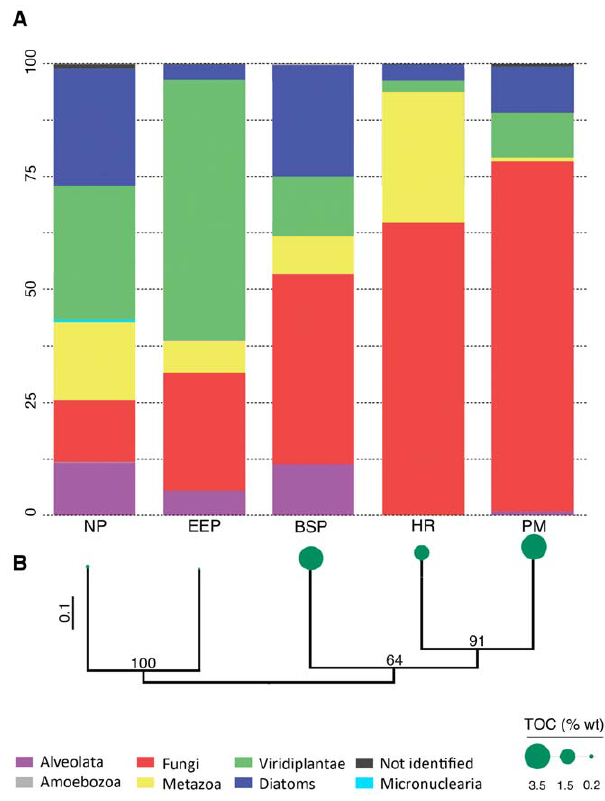
Figure 1. Alpha and beta diversity of pyrosequenced eukary- otic rRNA amplicons from five subseafloor sites representing various marine subsurface provinces. (a) Kingdom and phylum- level affiliation of eukaryotic rRNA sequences. Percentage of total reads is presented on the y-axis, samples were normalized to the number of sequences detected in the sample with the smallest number of sequences prior to comparison and UniFrac. (b) Hierarchical clustering of the eukaryotic rRNA dataset and phylogenetic distances between samples was calculated using weighted UniFrac. Bootstrap support values are shown on nodes. Green circles at the end of the branches are proportional to TOC values. See Table 1 for sample information. We divided the dataset into sequences affiliating with the 5 major groups detected: Viridiplantae, Metazoa, Bacillariophyta (Diatoms), Alveolata, and Fungi. Canonical correspondence analyses (CCA) paired with Multi-Response Permutation Proce- dure (MRPP) at multiple levels of taxonomic hierarchy identified groups correlating with TOC, dissolved inorganic carbon (DIC), sulfide, or sediment depth (Fig. 2 A-E). Sequences from plants